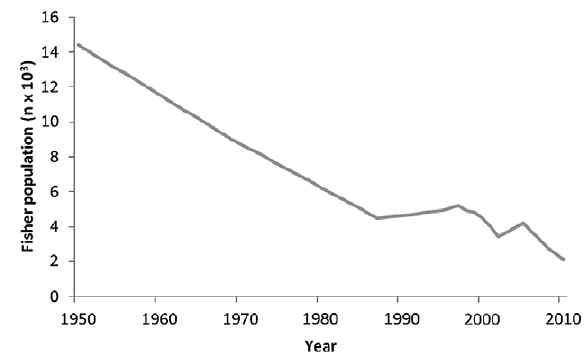
Fig. 2. – Number of artisanal boats in the Canary Islands, 1950-2010. Fig. 3. – Number of artisanal fishers in the Canary Islands,